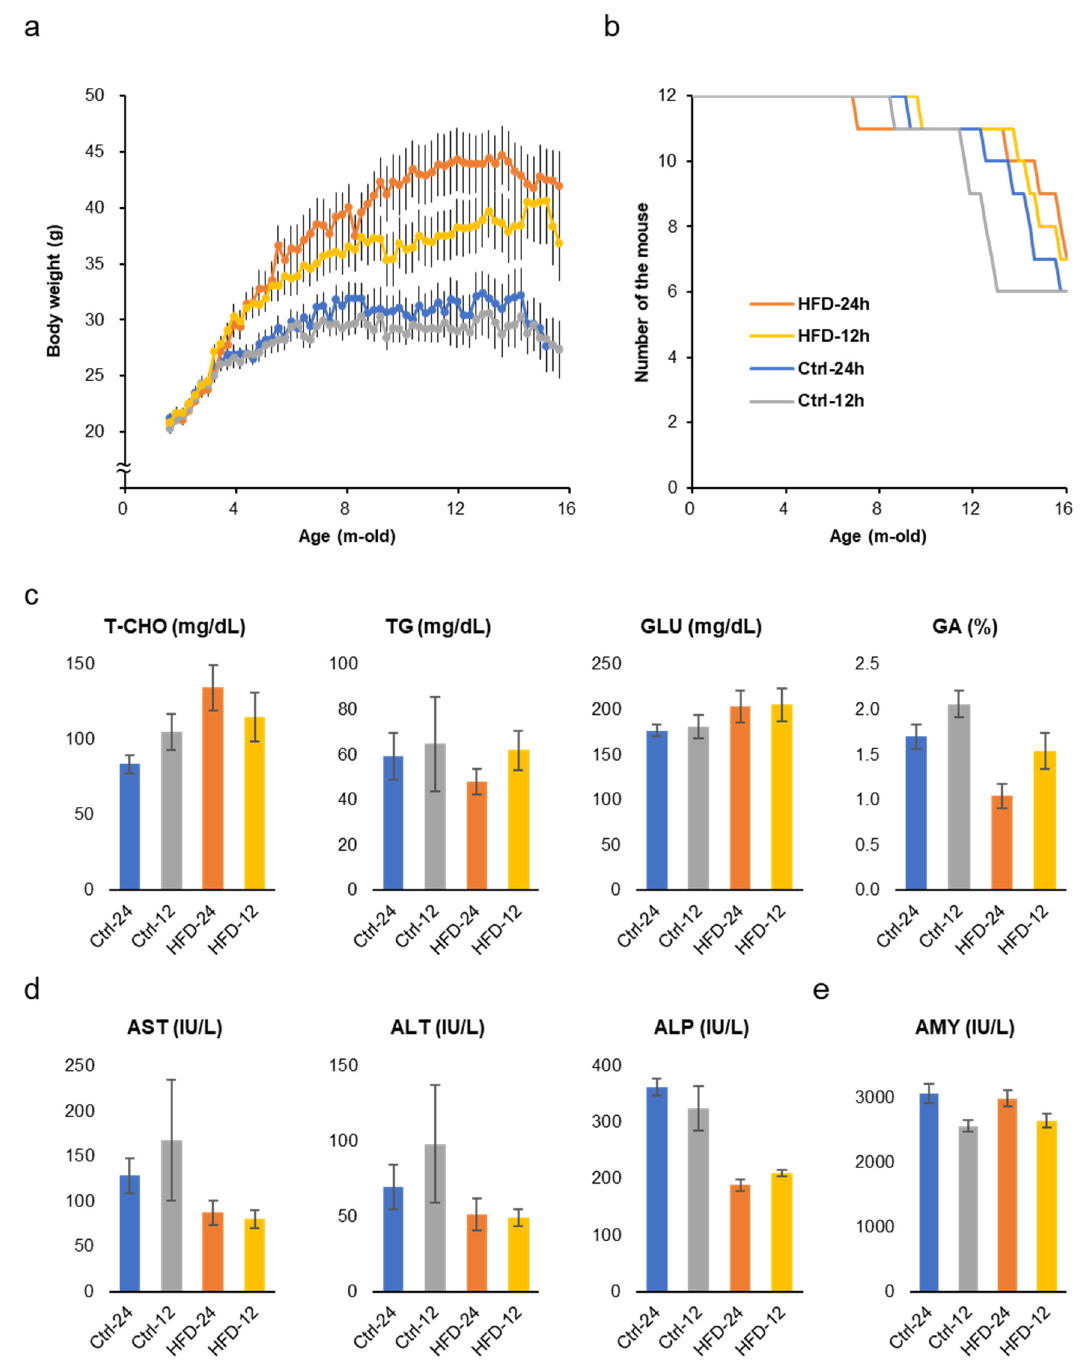
Figure 2. Body weight change, survival, and biomarkers in the serum: Changes in body weight ( a ) and survival ( b ) of SAMP8 mice throughout the experiment. Serum metabolic markers ( c ) and liver function markers ( d ) and a pancreatic marker ( e ) in 16 m-old SAMP8 mice ( N = 6–7 each group). The results of all the measured biomarkers and statistics are shown in Supplementary Table S2. T-CHO: total cholesterol; GLU: glucose; TG: triglyceride; GA: glycoalbumin; AST: aspartate aminotransferase; ALT: alanine aminotransferase; ALP: alkaline phosphatase; AMY: amylase.